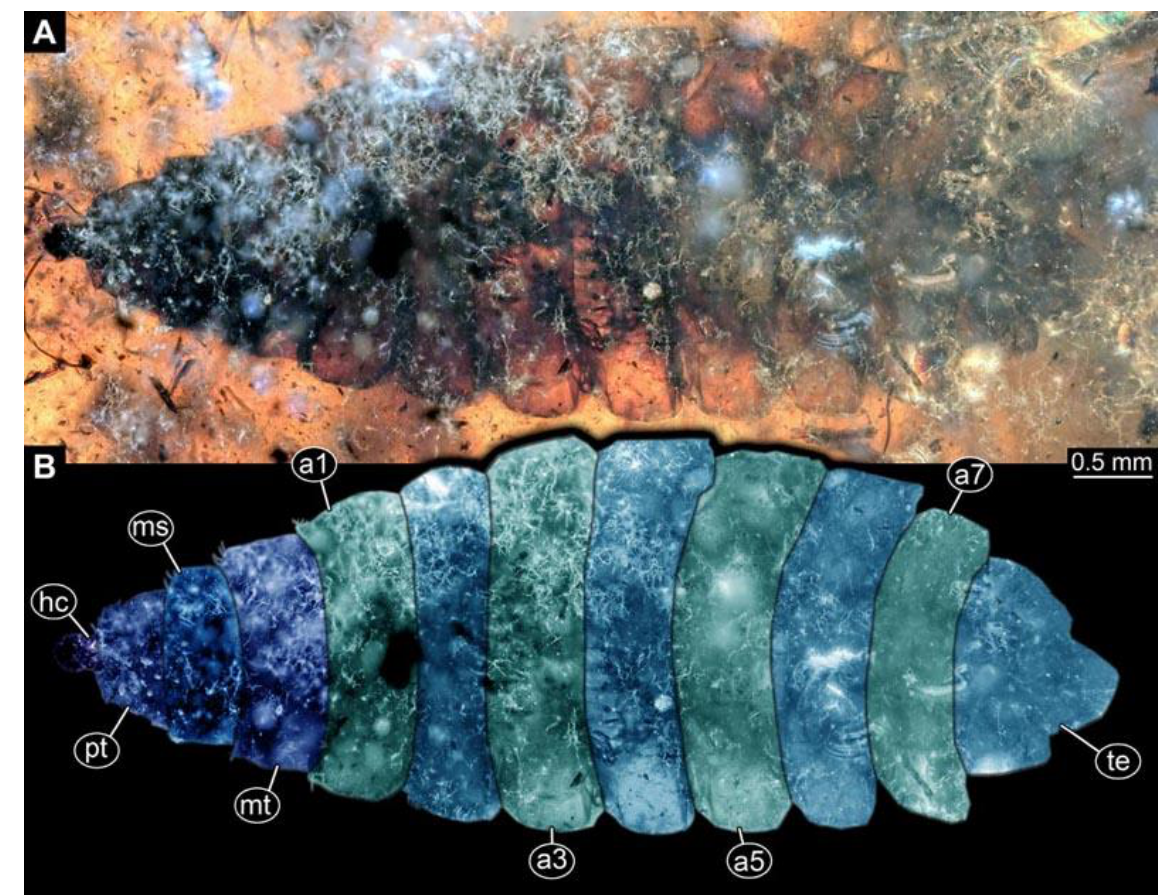
Figure 16. Fossil larva of morphotype 7, specimen PED 1107. ( A ). Ventral view. ( B ). Colour-marked. Abbreviations: a1–a7 = abdomen units 1–7; hc = head capsule; ms = mesothorax; mt = metathorax; pt = prothorax; te = trunk